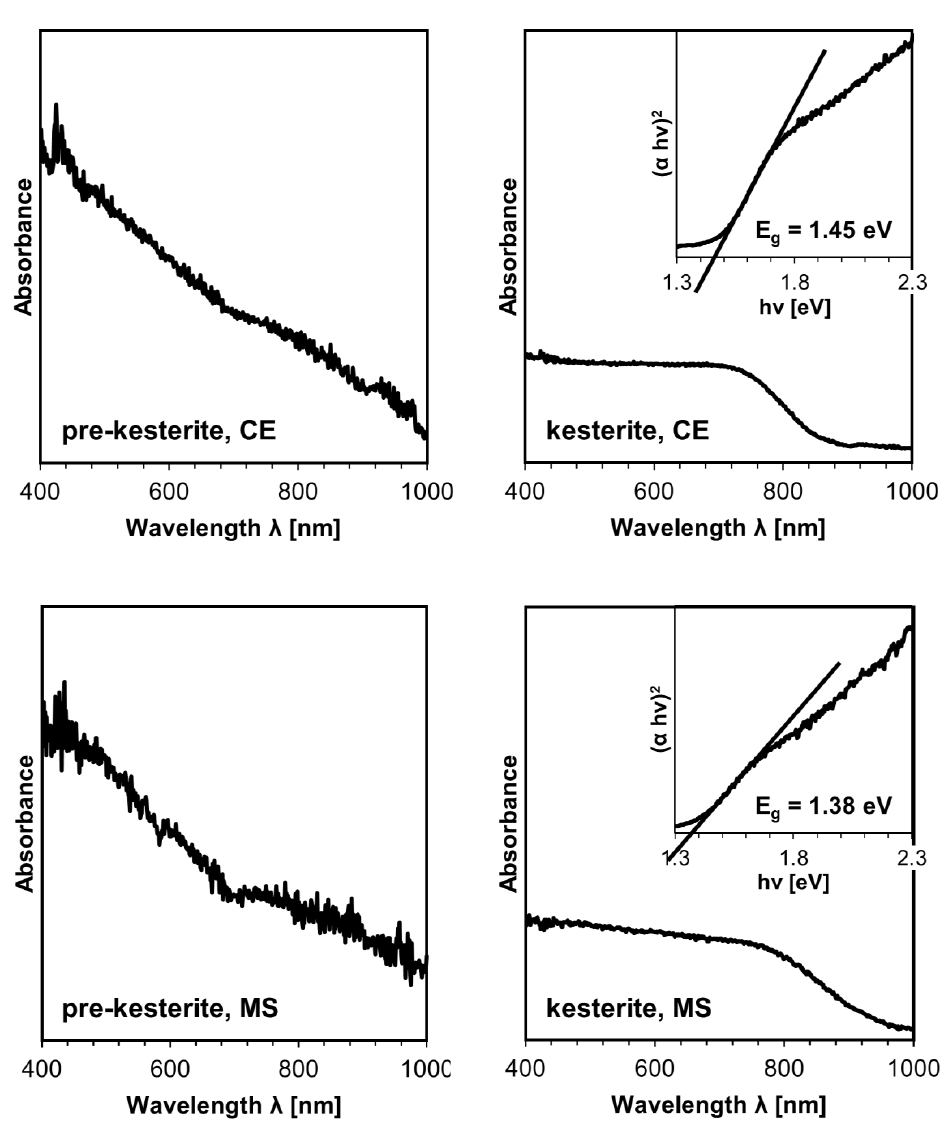
Figure 6. UV-vis spectra for the nanopowders from the CE system ( top row) and MS system ( bottom row). Spectra for the annealed kesterites have inserts of Tauc ( α h ν ) 2 vs. h ν [energy] plots ( α approximated by Kubelka–Munk transformation) and include the calculated energy band gaps E g . Note the nonspecific spectra for both prekesterites with defunct semiconductor